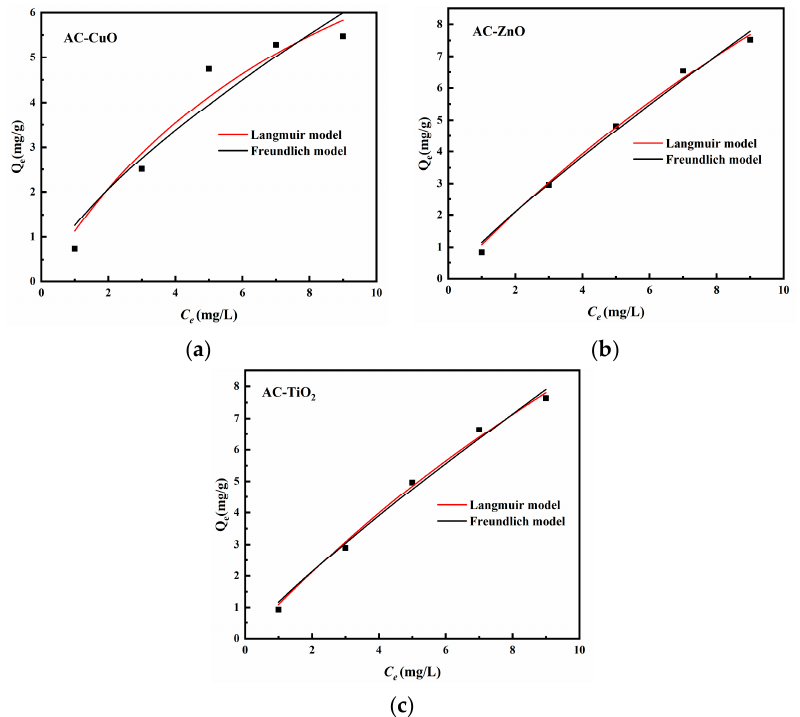
Figure 16. Isotherm model of ( a ) AC-CuO, ( b ) AC-ZnO, and ( c ) AC-TiO 2 . Table 6. Summary of correlation coefficients for kinetic model fitting.